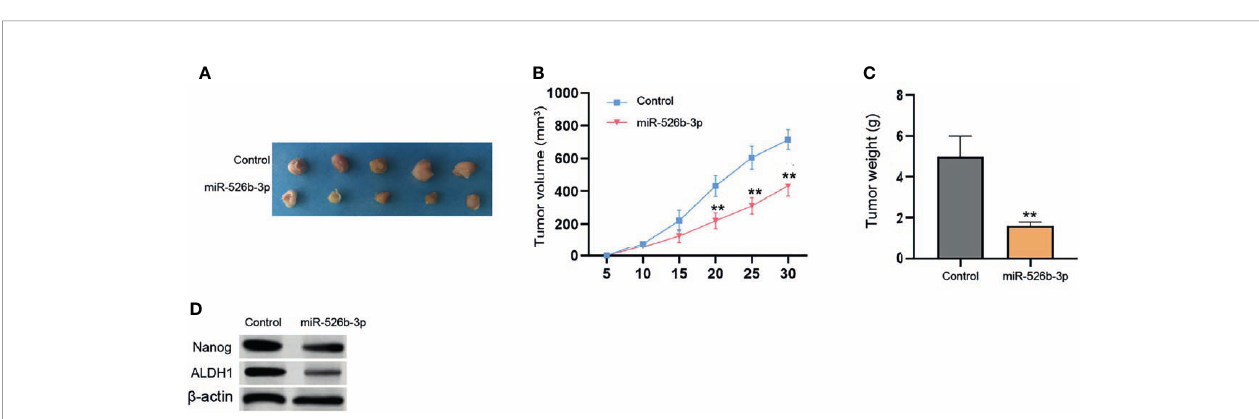
FIGURE 2 | MiR-526b-3p attenuates breast cancer cell growth in vivo . (A – D) The nude mice ( n = 5) were injected with MCF-7 cells transfected with control mimic or miR-526b-3p mimic. The tumorigenicity in vivo was observed. The representative tumor tissues (A) , tumor volume (B) , and weight (C) were presented. Data are mean ± SD: ** p <